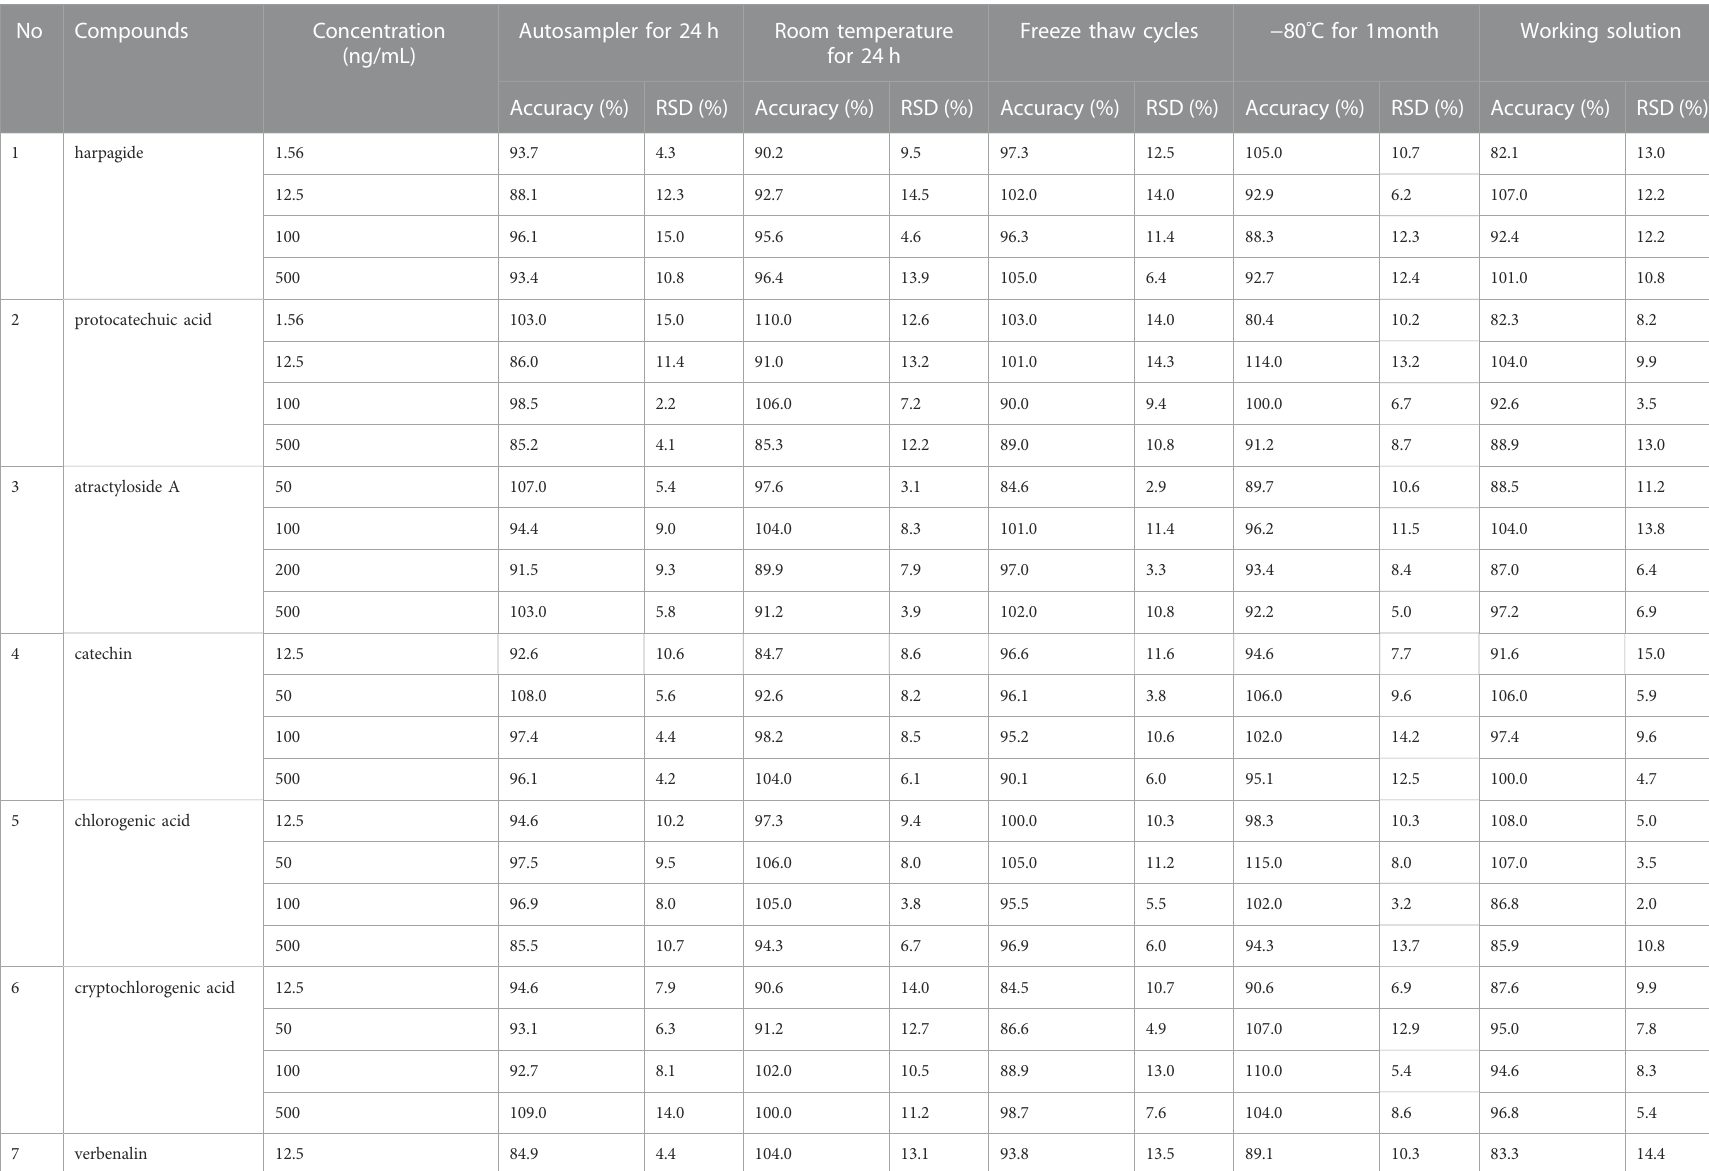
TABLE 2 Stability of 33 analytes in